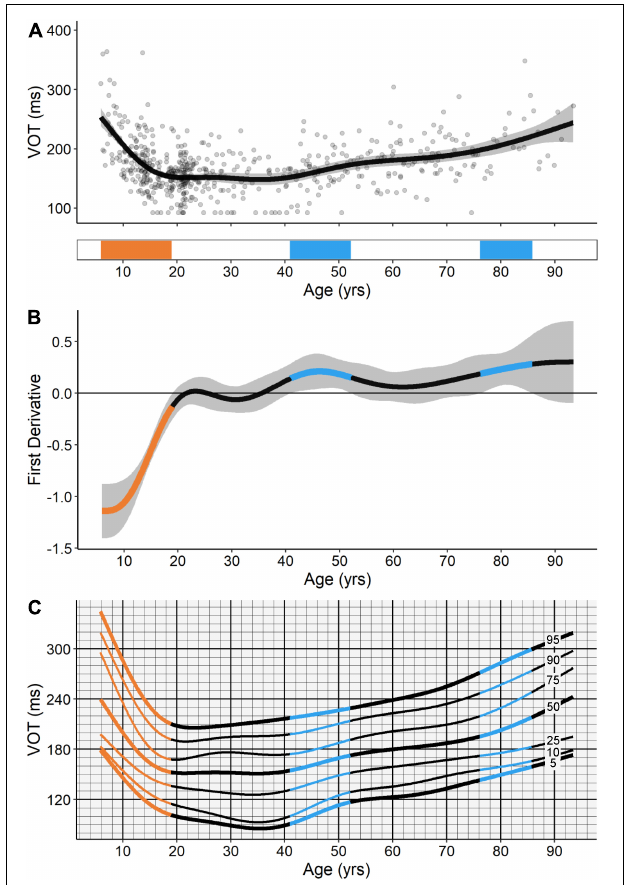
FIGURE 6 | (A) GAM fit and significant periods of change for voluntary override time (VOT). Scatter points are individual participants, black curve is the GAM fit, and gray ribbon is the 95% confidence interval. Bottom tile indicates significant periods of developmental-related (orange) and aging-related (blue) change. (B) First derivative of the GAM fit shown in panel (A) . Negative values indicate improvements in task performance (i.e., decreases in VOT) and positive values indicate declines in task performance (i.e., increases in VOT). Significant periods of developmental-related (orange) and aging-related (blue) change were identified at the ages where the confidence intervals of the first derivative of the GAM did not contain zero ( p < 0.05). (C) A hypothetical “cognitive growth curve” for VOT consisting of the 5th, 10th, 25th, 50th, 75th, 90th, and 95th percentile curves for the measure.